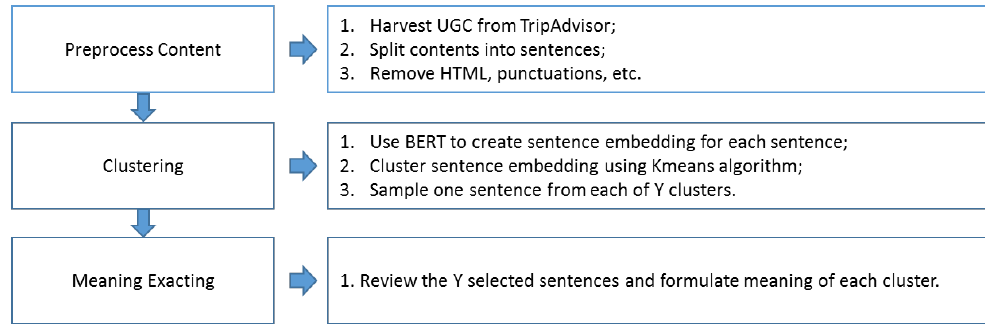
Figure 3. The proposed architecture of the process.